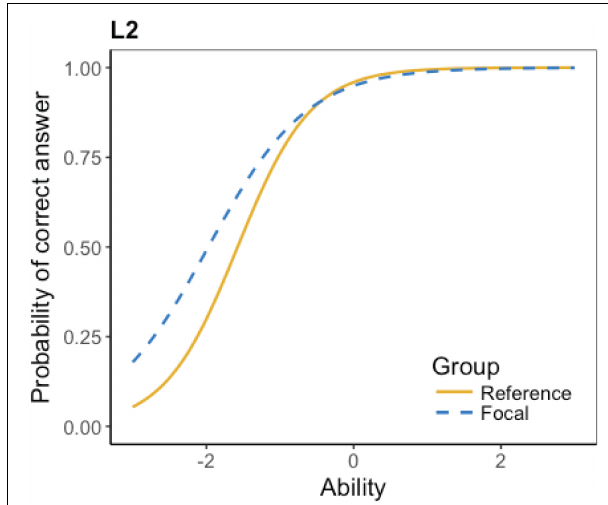
FIGURE 3 | ICC of listening L2.